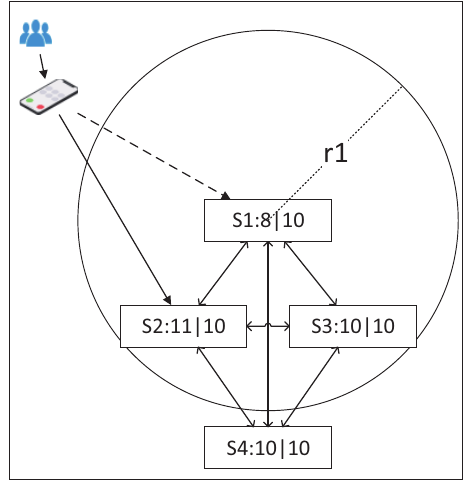
Figure 1. Example of renting